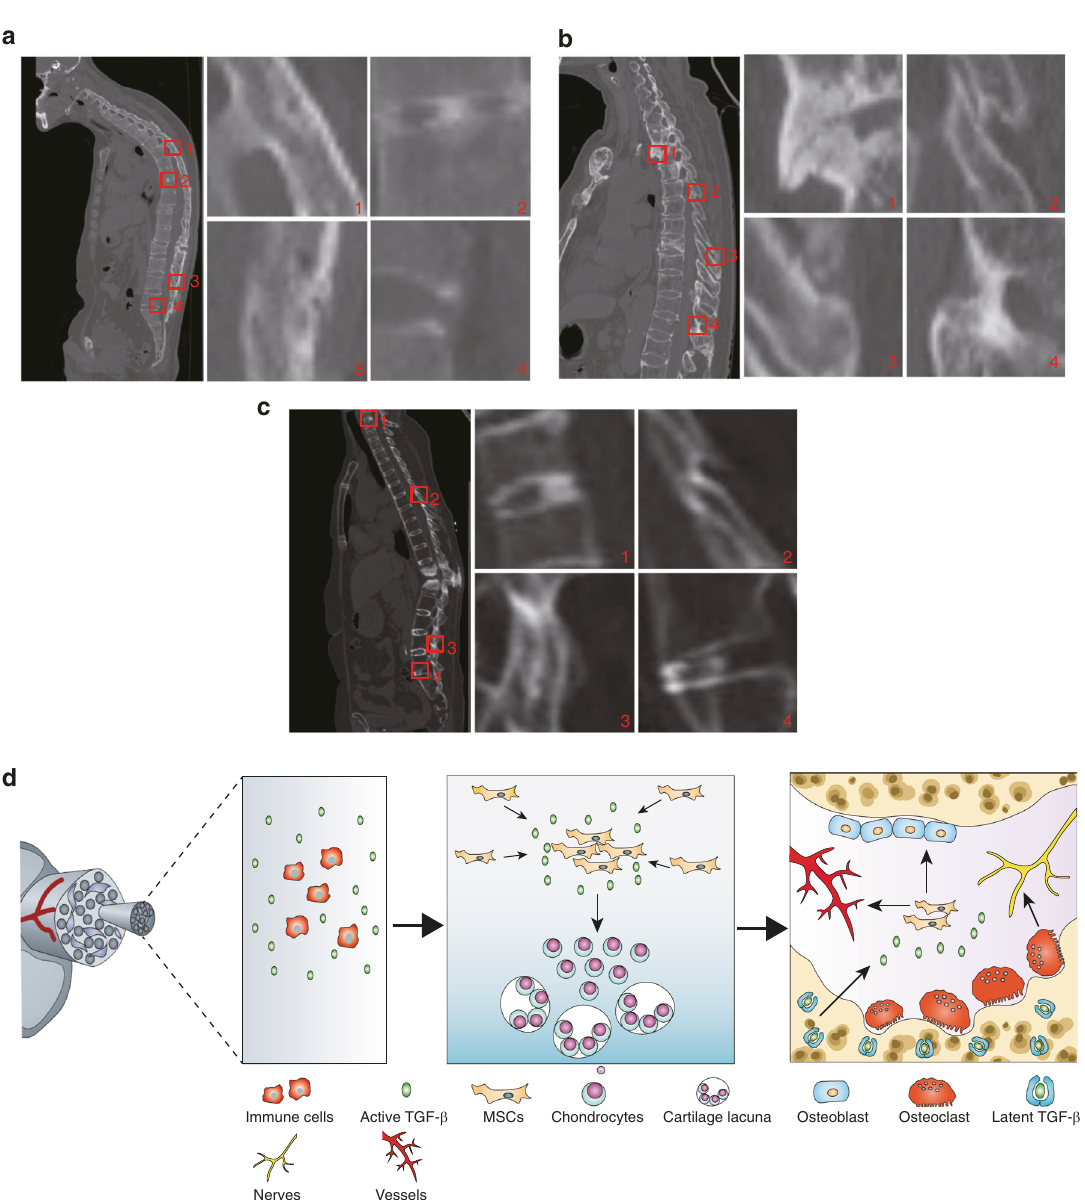
Fig. 6 Ossi fi cation in spine soft tissues by CT in AS patients. a Male, aged 45 years. 1 Supraspinous ligament and Interspinous ligament. 2 Vertebral disk. 3 Supraspinous ligaments. 4 Posterior longitudinal ligaments. b Male, aged 37 years. 1 Anterior longitudinal ligament. 2 Interspinous ligament. 3 Interspinous ligament and supraspinous ligament. 4 Interspinous ligament and ligamentum fl avum. c Female, aged 33 years. 1 Vertebral disk. 2 Interspinous ligament and Ligamentum fl avum. 3 Interspinous ligament. 4 Anterior longitudinal ligaments. The right four panels show magni fi ed views of the red boxed area in the left panels. d Hypothetical diagram of pathological progression of AS. Excessive TGF- β is produced by abundant immune cells due to autoimmune disease, then TGF- β recruits MSCs results in chondrocytes proliferation, hypertrophy, and calci fi cation. Numbers of giant osteoclasts keep resorbing calci fi ed cartilage and freeing TGF- β from lap, continuous high level of TGF- β recruits MSCs for vessels formation and osteoblasts differentiation, osteoclasts also induce the innervation surgical treatment of spinal fracture. Pathological specimens of hip from individuals. Pathological specimens of spine were collected joint were collected from 5 patients with AS (5 males with no from 32 patients with AS (29 males and 3 females with no fi brous fi brous dysplasia of bone or other blastic bone metastases, dysplasia of bone or other blastic bone metastases, nonsmoking, nonsmoking, aged 33 – 64 years, with disease duration of 14 – 37 aged 26 – 64 years, with disease duration of 10 – 40 years) who met years) who met the 1984 modi fi ed New York criteria after total hip the 1984 modi fi ed New York criteria after spinal wedge joint replacement. Healthy specimens of hip joint were collected osteotomy. HO was fi rst accessed using the CT scan results of from 5 patients (5 males with no fi brous dysplasia or other blastic each patient before enrollment and identi fi ed using the μ CT scan bone metastases, nonsmoking, aged 55 – 69 years) after surgical after collection. Healthy specimens of spine were collected from 8 treatment of fracture. The obtained specimens were de fi ned patients (5 males and 3 females with no fi brous dysplasia or other based on the μ CT results and included the following: the hip joint blastic bone metastases, nonsmoking, aged 23 – 65 years) after